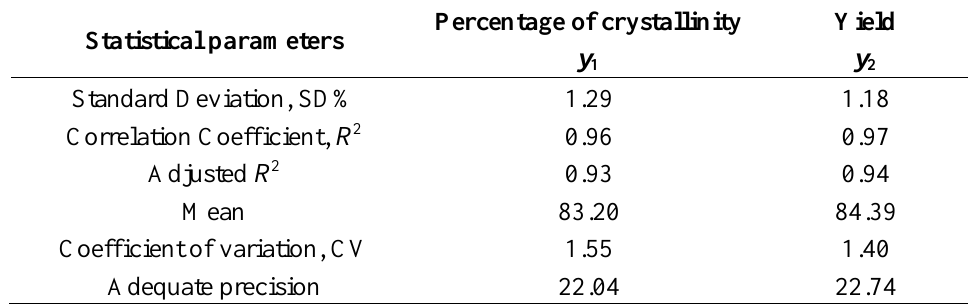
Table 1. Statistical parameters for ANOVA for the model regression for the percentage of crystallinity and